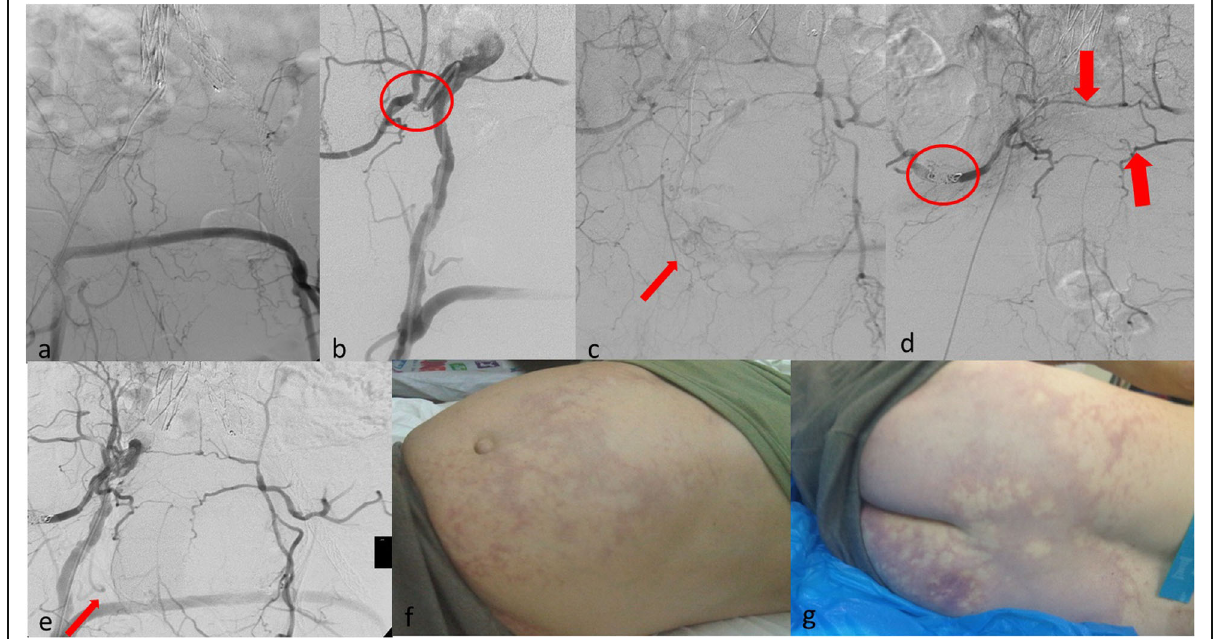
Fig. 3 Haemodynamically unstable 61-year old male patient with history of inoperable bladder cancer, radiotherapy previous EVAR, fem-fem bypass graft and intractable haematuria not responding to any conservative method. a DSA depicting previous unilateral EVAR and extra- anatomic fem-fem bypass. b Selective catheterization of the right internal iliac artery (IIA) demonstrating a significant stenosis of its origin (circle). c DSA with the catheter at the origin of the IIA demonstrating a blush of contrast at the site of bleeding (arrow). d As the anterior division of the IIA could not be selectively catheterized, protective coil embolization of the posterior division (circle) and life-saving particle embolization (40 μ m for better penetration) from the origin of the IIA was performed. Note the anastomosis between the right and the left middle and lateral sacral arteries (arrows). e After the delivery of 1 vial of micro-particles no blush was evident (arrow). f and g 30 mins after embolization the patient developed severe pain and marked ischemia of the buttock and the anterior abdominal wall. He was managed by the anaesthesiology team and died of myocardial infarction 10 days after index